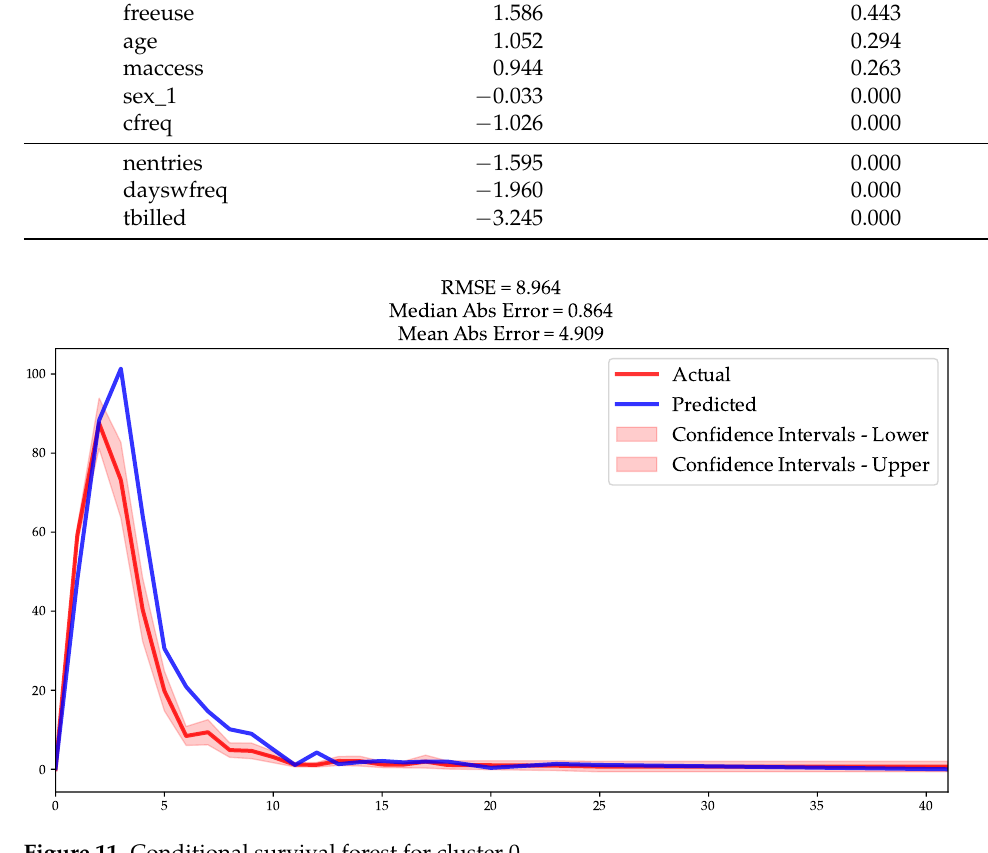
Figure 11. Conditional survival forest for cluster 0. The cluster 4 actual versus predicted model presented a mean absolute error of 2.29 customers, median absolute error of 0.717, and Root Mean Square Error of 3.32 (Figure